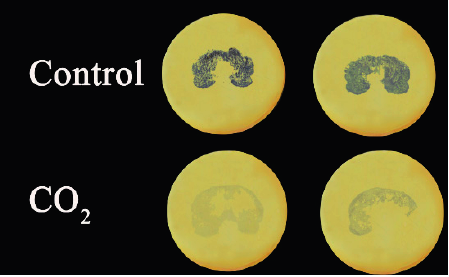
Figure 1. Effect of CO 2 treatment on soluble tannin of “Mopan” fruit at 20 °C. Mature fruit were treated with CO 2 (~95%, v / v , open circles, one day) and air (control, open squares), separately. Error bars represent standard error from three biological replicates.